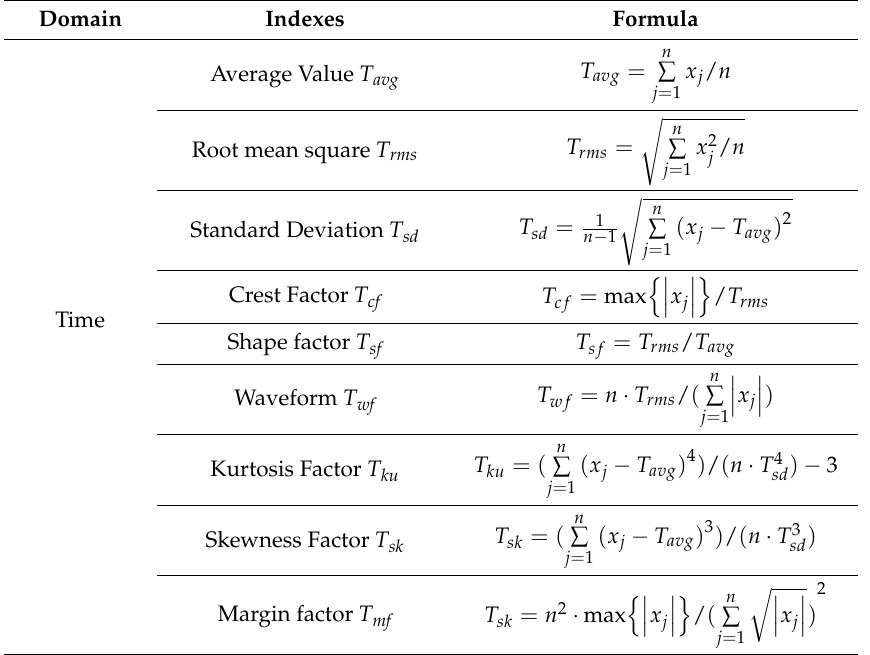
Table 2. Nine time domain statistical parameters.